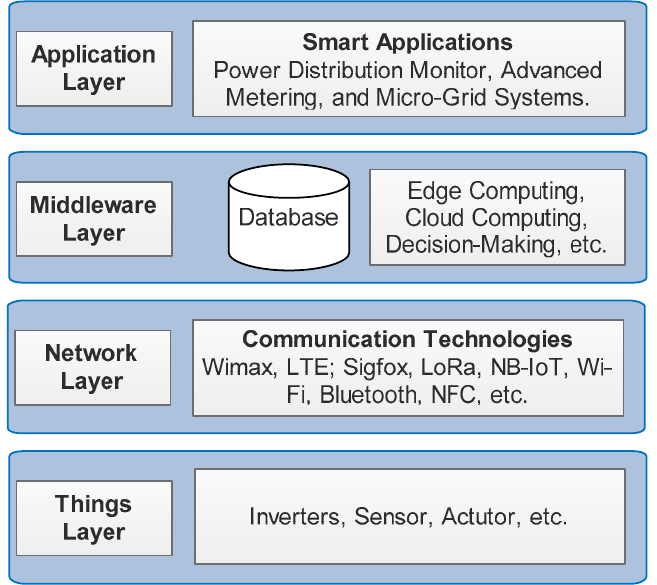
Figure 3. An illustration of the IoT-based SG architecture.